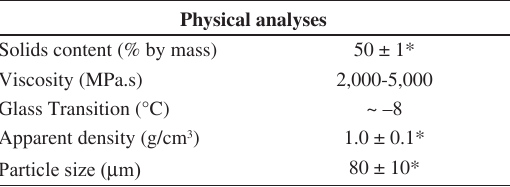
Table 2. Physical characteristics of styrene-acrylic copolymer dispersion. Physical analyses